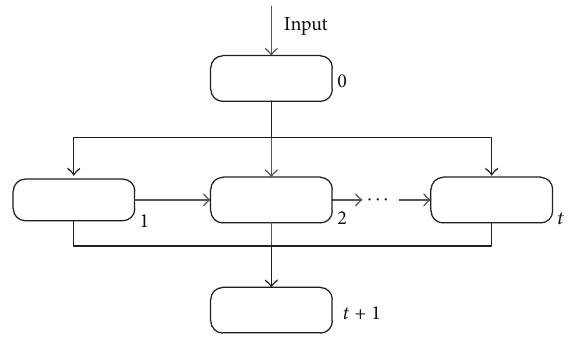
Figure 1: Cell structure for the ECTPPI-Apriori